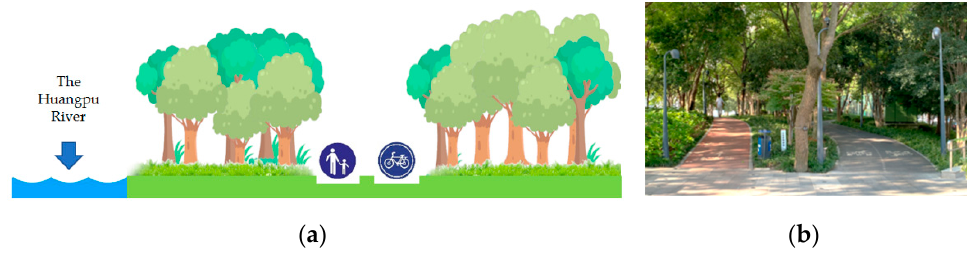
Figure 2. The natural form of greenway along the Huangpu River in Shanghai (natural greenway), seen from the perspective of ( a ) greenway designer and ( b ) greenway user, can effectively establish the organic connection between man and nature because the plants are luxuriant and the vegetation coverage rate is high along the natural greenway. Whereas, the routes of natural greenways are often uneven, with slopes and curves, and they are often narrow and crowded, causing the interference of citizens during sports or rest.